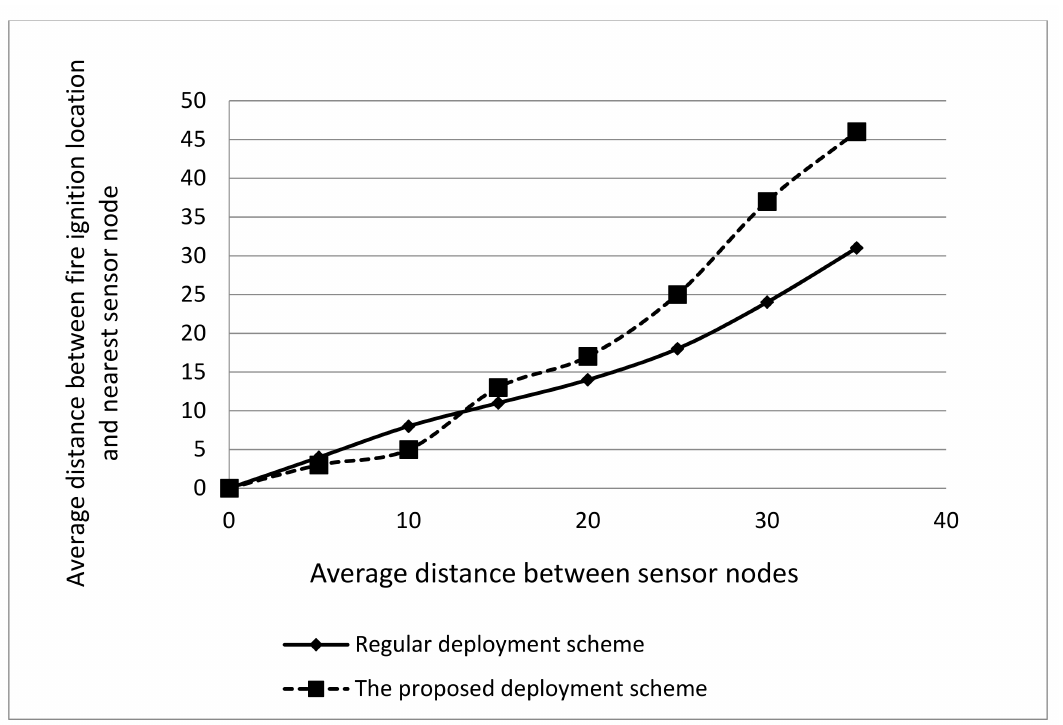
Figure 3. Average distance between fire ignition and nearest sensor node of regular deployment and the proposed deployment